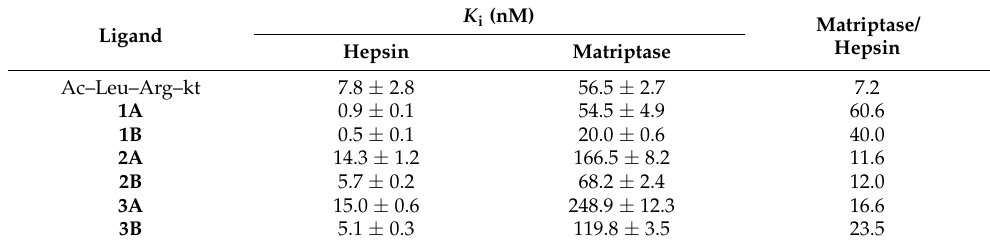
Table 1. K i (nM) of ligands for hepsin and matriptase.